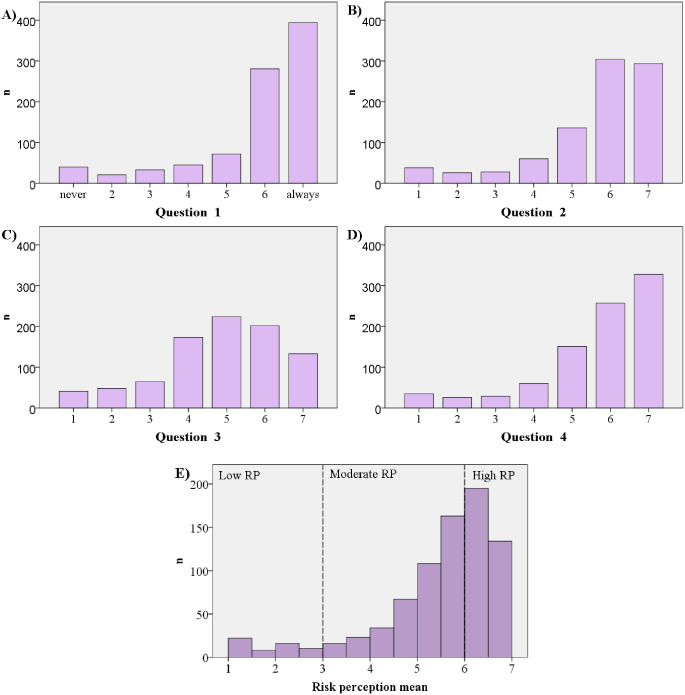
Distribution of the answers related to the participants risk perception.(A) COVID 19 is a serious problem?; (B) I am worried about getting COVID 19?; (C) It is likely that I will get COVID 19?; (D) COVID 19 is dangerous?; and (E) Risk perception mean.